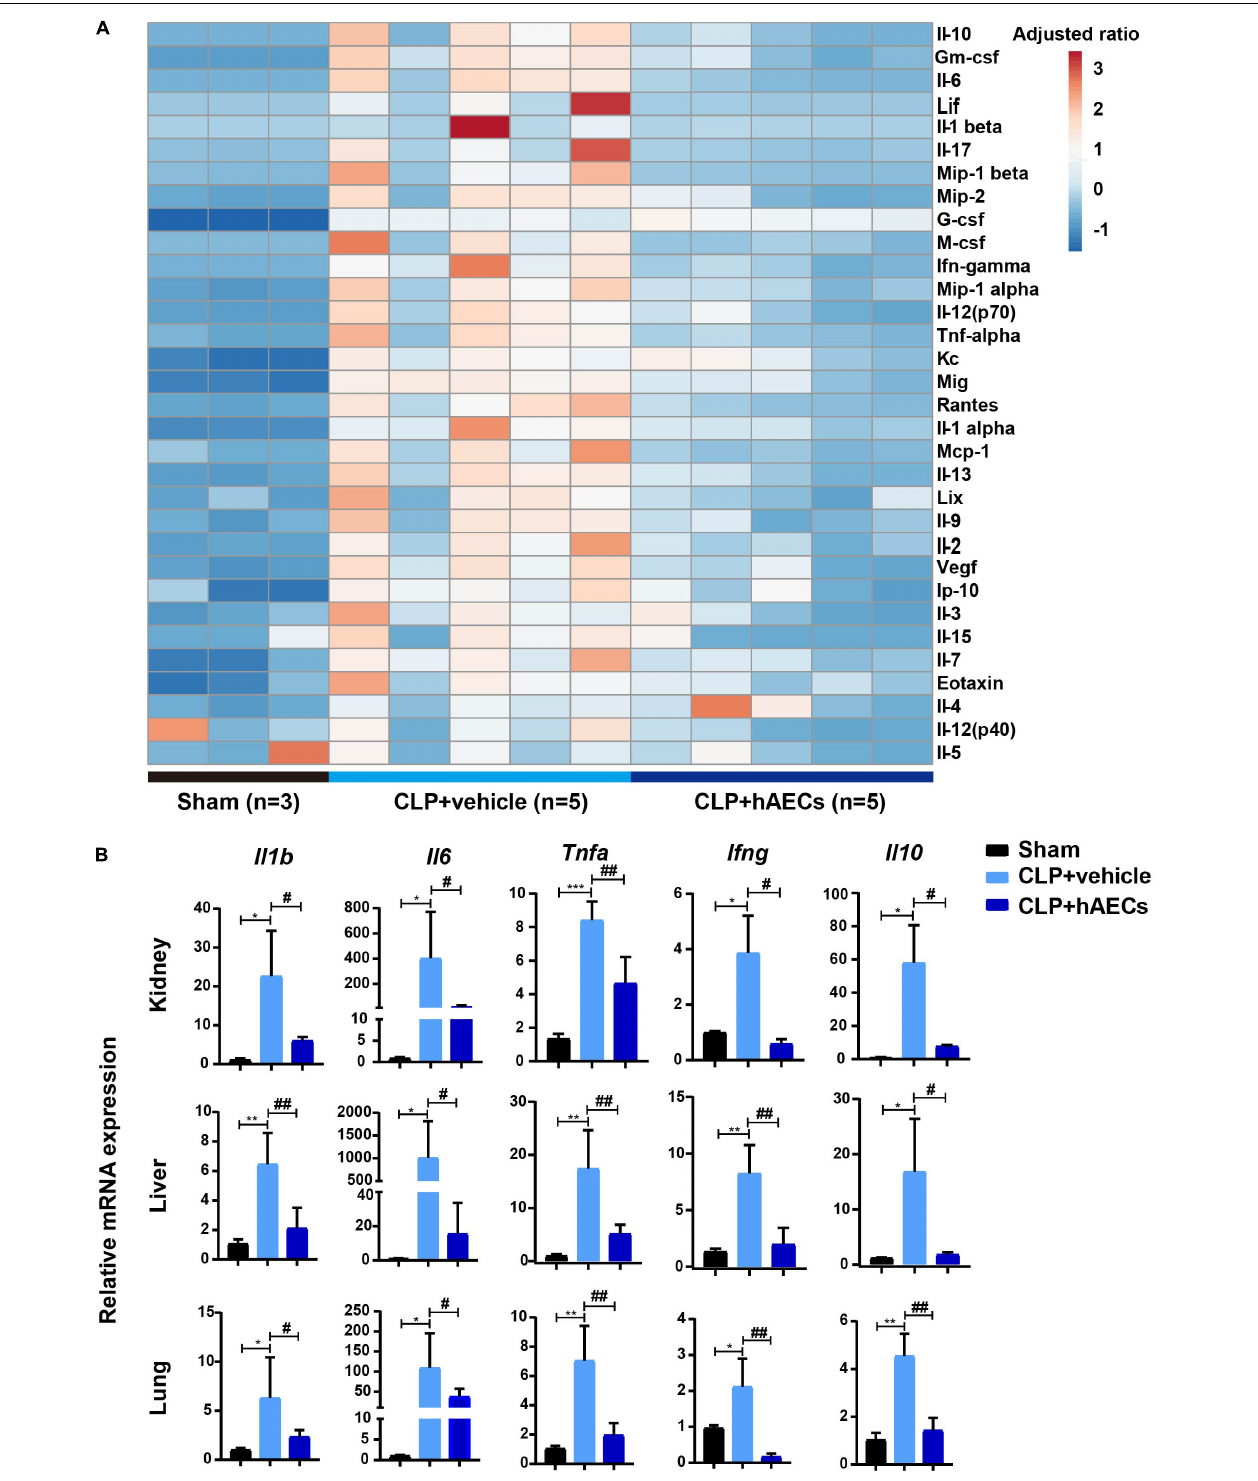
FIGURE 3 | hAECs suppress the levels of inflammatory mediators in septic mice. (A) Heat map shown the changes of the protein levels of inflammatory mediators in the plasma of septic mice. (B) The messenger RNA (mRNA) expression of inflammatory mediators in kidney, liver, and lung of septic mice 16 h after CLP with hAECs or vehicle administration. * P < 0.05, ** P < 0.01, *** P < 0.001 vs. the sham group; # P < 0.05, ## P < 0.01 vs. the CLP + vehicle group.